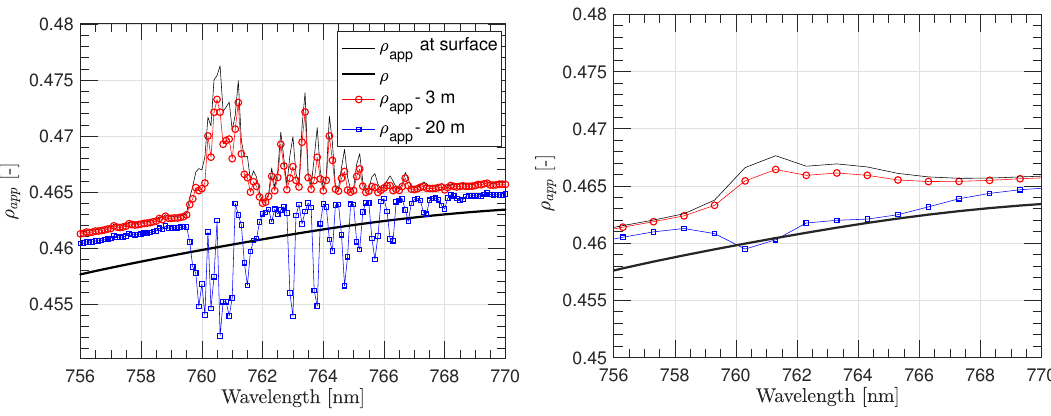
Figure 9. Apparent reflectance ( ρ app ) derived at: ( a ) high (SSI 0.1 nm - SR 0.1 nm); and ( b ) low (SSI 1 nm–SR 2 nm) instrument resolutions for 3 m (red circles) and 20 m (blue squares) sensor heights above the TOC. The solid thin black lines correspond to the ρ app derived at surface level. The solid thick black line corresponds to the surface reflectance used here as a reference.